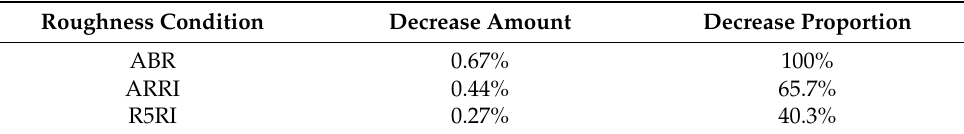
Figure 12. Comparison of compressor flow efficiency characteristics under different roughness conditions. Table 3. The decreased amount and proportion of peak total efficiency of the compressor under different roughness conditions.